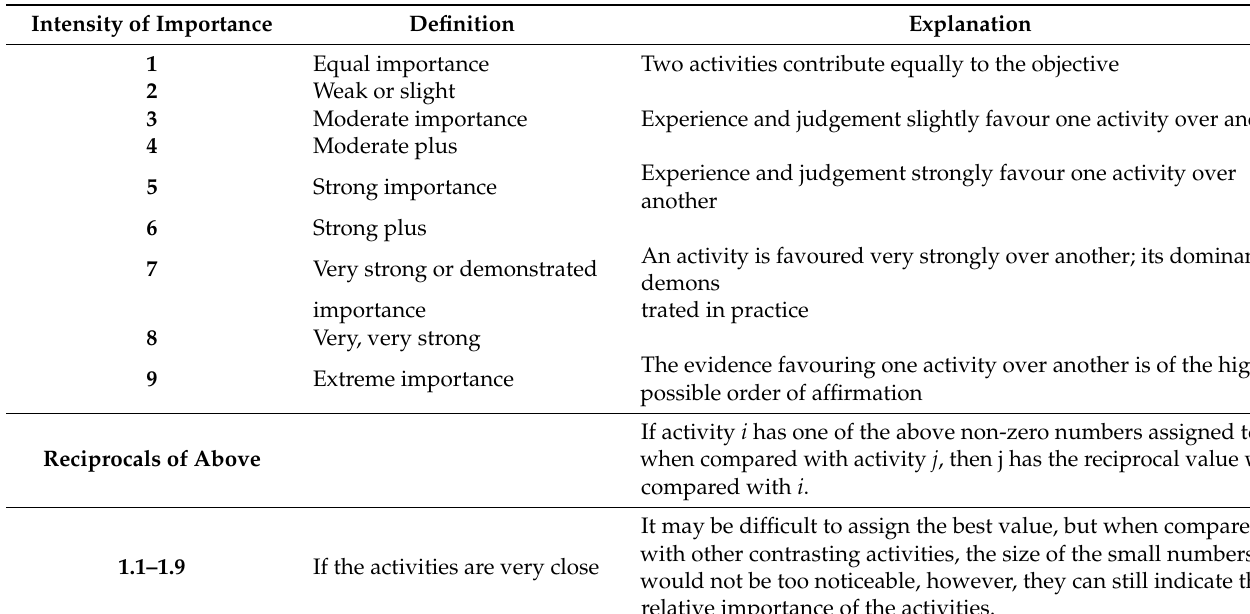
Table 1. Saaty’s scale (Saaty [89]).